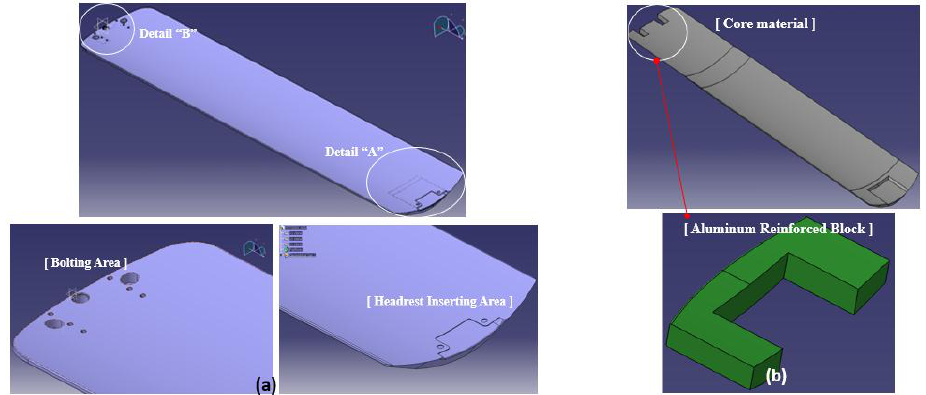
Figure 4. Shape of Sandwich composite Cradle; ( a ) 3-dimensional Shape of Cradle, ( b ) design of Core and the reinforced block.